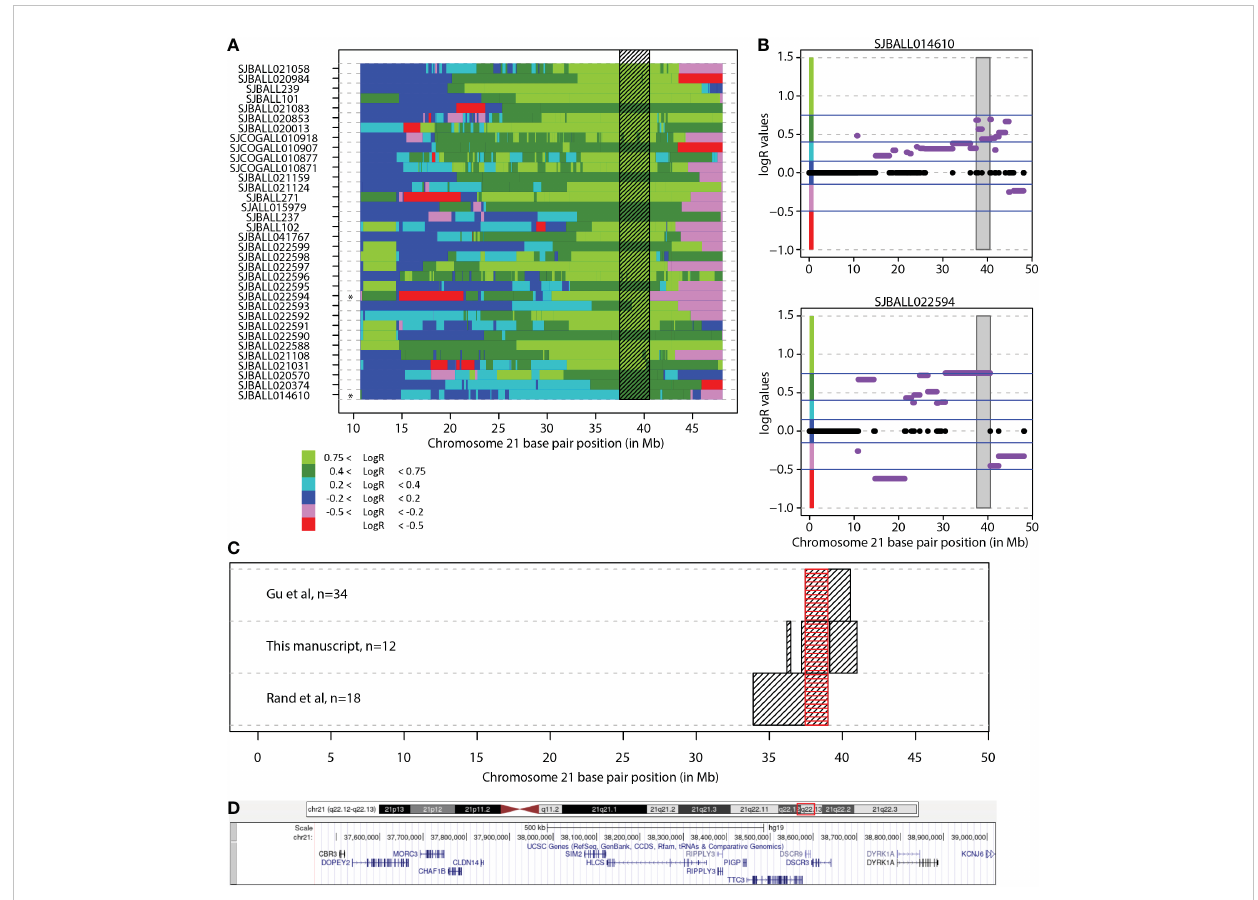
FIGURE 2 Combined common region of ampli fi cation. (A) Segmented chromosome 21 LogR values in 34 iAMP21 cases from the study of Gu et al. Each row depicts one case. Shaded region shows the common region of ampli fi cation in this cohort (CRA). Black stars depict cohort CRA de fi ning cases. Chromosome 21 base pair position is shown on the x-axis (reference genome hg19). (B) Chromosome 21 copy number pro fi le of the two cases from Gu et al. that de fi ne the region. Purple lines show the segMean values, values between -0.2-0.2 were absent from supplement, indicated in black. Chromosome 21 base pair position is shown on the x-axis (reference genome hg19), with LogR values on the y-axis. Shaded region shows the common region of ampli fi cation. Blue lines show the LogR value borders as used in fi gure 2A, colours on the y-axis represent the colours as shown in fi gure 2A. (C) The overlap of the CRA in all three studies. Black boxes show the region in each study, red box shows the overlap between all studies. Chromosome 21 base pair position is shown on the x-axis (reference genome hg19). (D) Overview common region of ampli fi cation. Snapshot taken from UCSC genome browser (Reference genome hg19/GRCh37; location chr21:37,452,074-39,019,555). DSCR3 is also known as VPS26C